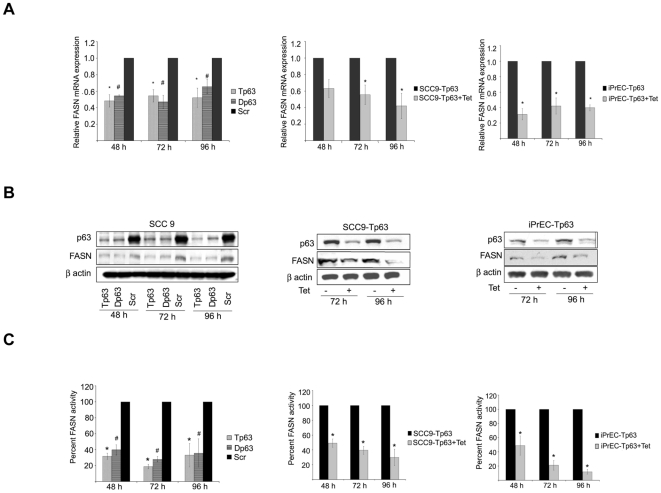
p63 silencing induces a decrease in FASN expression and enzymatic activity.A. Quantitation of FASN mRNA by real time RT-PCR in SCC9 cells transfected with Tp63 or Dp63 siRNA relative to cells transfected with Scr siRNA (left panel). Quantitation of FASN mRNA in SCC9-Tp63 and iPrEC-Tp63 cells treated with tetracycline relative to the correspondent untreated cells (middle and right panels, respectively). Data are shown as means +/− standard error and are representative of three independent experiments. B. Immunoblot analysis of FASN in SCC9 cells transfected with Tp63, Dp63 or Scr siRNAs (left panel), in SCC9-Tp63 cells with or without treatment with tetracycline (middle panel) and in iPrEC-Tp63 cells with or without treatment with tetracycline (right panel). C. Quantitation of C14 incorporation within cellular lipids in SCC9 cells transfected with Tp63 or Dp63 siRNA relative to cells transfected with Scr siRNA (left panel) and in SCC9-Tp63 and iPrEC-Tp63 cells treated with tetracycline relative to the correspondent untreated cells (middle and right panels, respectively). Data are shown as means +/− standard error and are representative of three independent experiments.